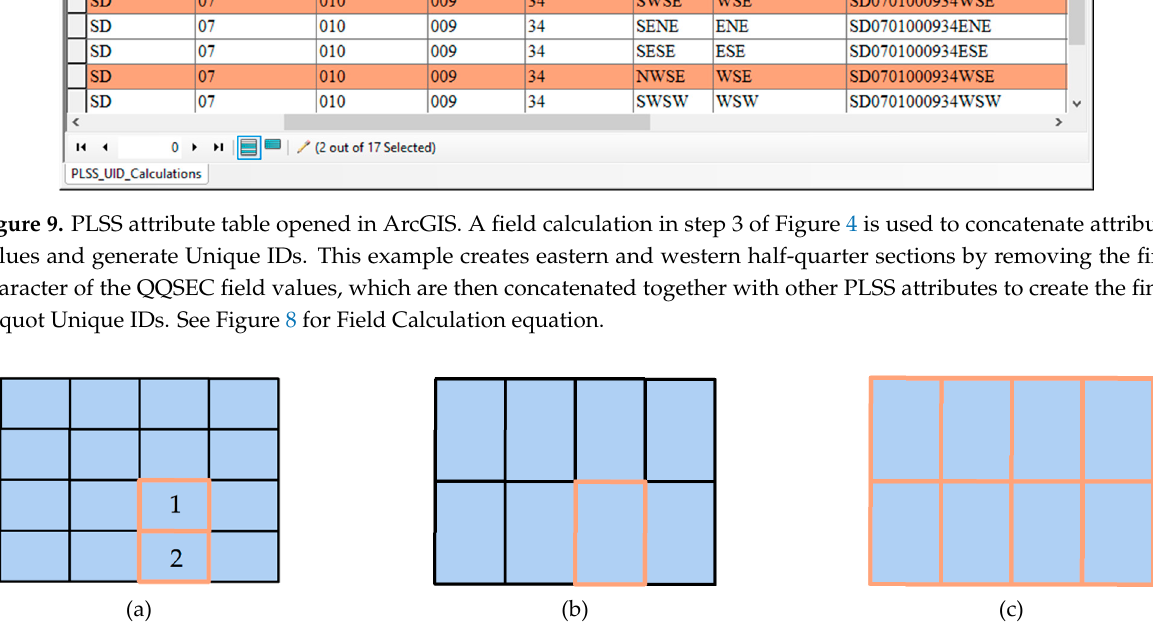
Figure 10. ( a ) The NW quarter of the SE quarter (1), and the SW quarter of the SE quarter section (2) are highlighted above and also in the attribute table in Figure 9. ( b ) The two quarter-quarter sections are merged together with the Dissolve tool, see step 4 of Figure 4. ( c ) For each section, 8 eastern/western half quarter sections are created. This is just one example of a typical land description. See Table 1 for other aliquot combinations.